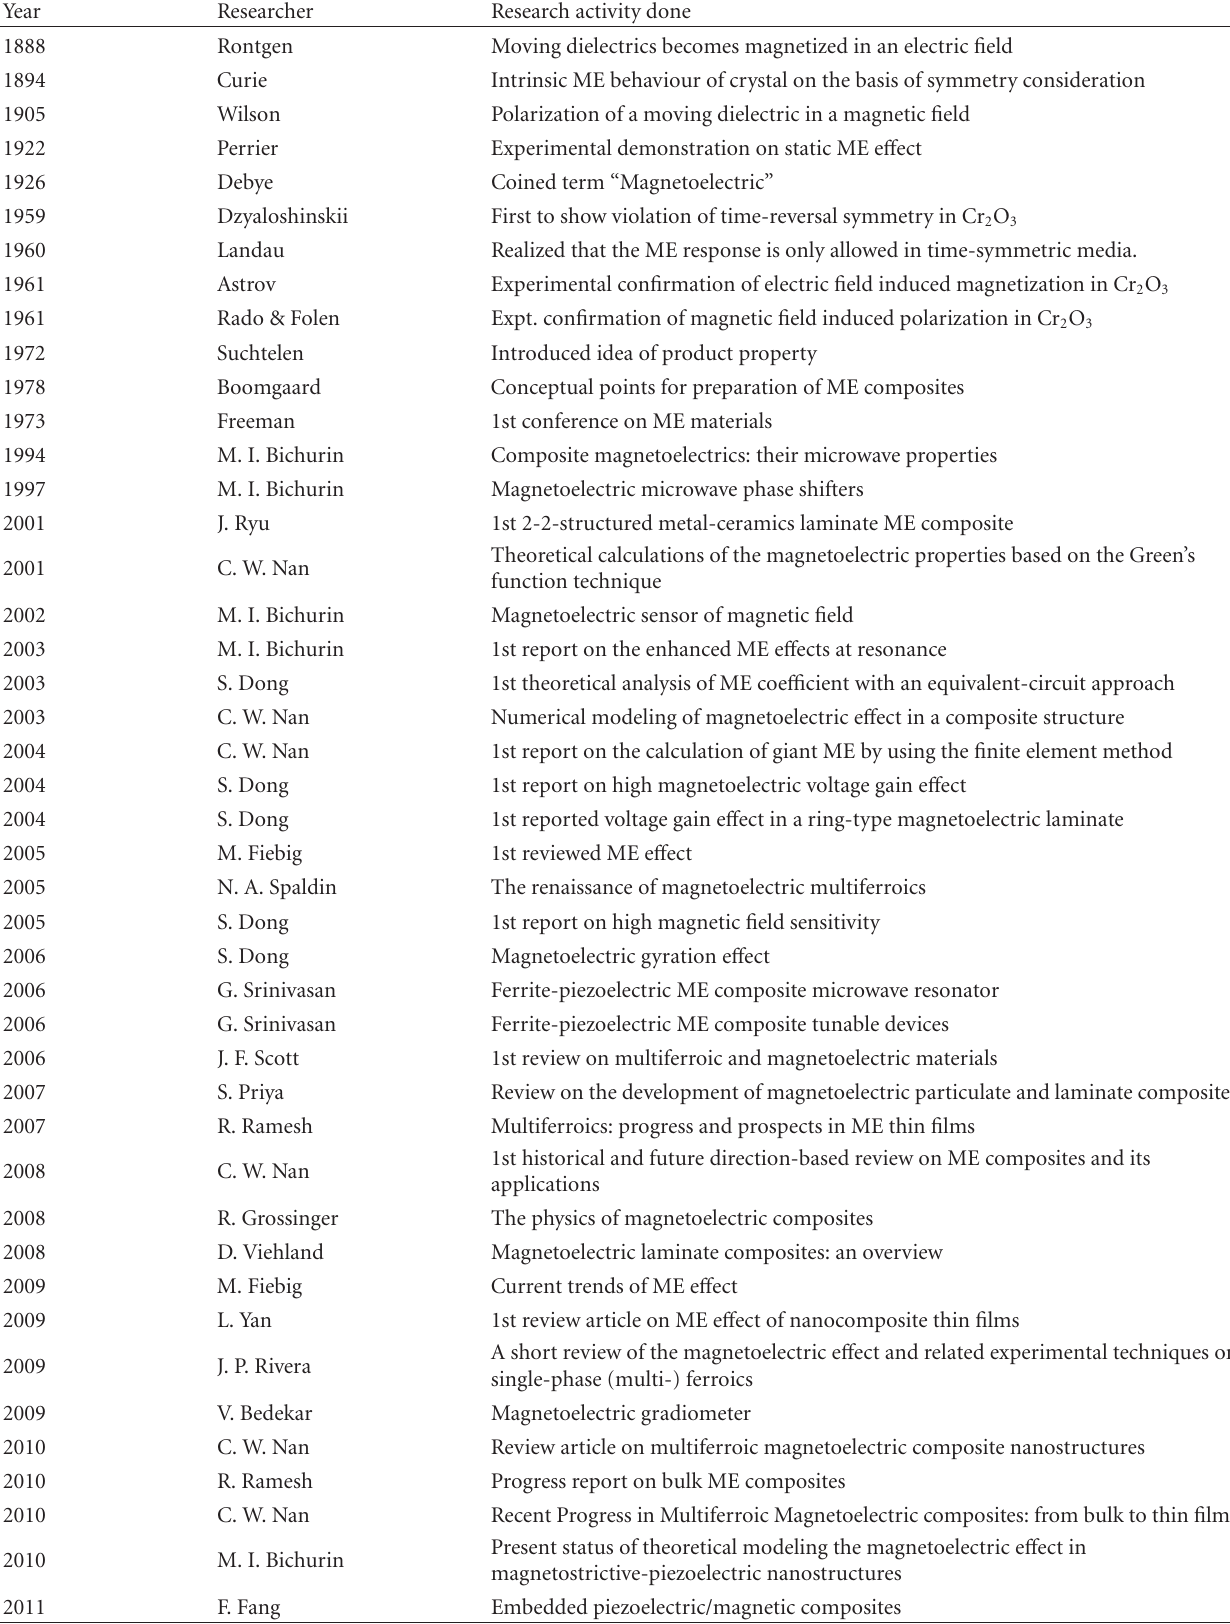
Table 1: Historical development of ME e ff